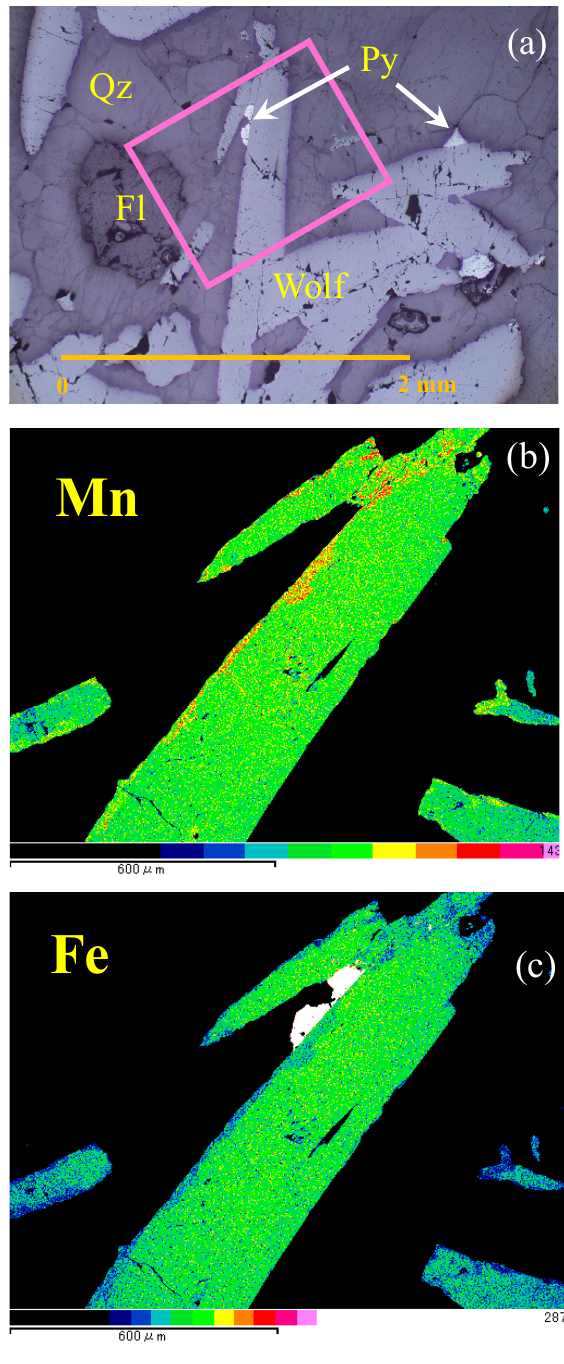
Figure 5. ( a ) Photomicrograph of a wolframite-bearing quartz vein with pyrite and fluorite (82032404) from No. 7 vein at W20 on level − 4L (57 m above sea level, Figure 4). Elemental maps of wolframite by SEM-EDS are shown for ( b ) Mn and ( c ) Fe. The analysis area for ( b , c ) is designated by the rectangular frame in Figure 5a. High content (Mn or Fe) corresponds to the right end of each color bar (qualitative scale). Qz: quartz, Wolf: wolframite, Py: pyrite, Fl: fluorite. Quantitative analyses of a wolframite grain (82032404, Table 1) from the No. 7 vein at − 4L (57 m above sea level, Figure 4) for Mn and Fe by EPMA are shown in Table 3 and Figure 6. The MnO/(MnO + FeO) ratio ranges from 42 to 65 mol%. The ratio in the center of the wolframite grain is around 43 mol%, while it increases to 65 mol% at the rims (Fig- ure 6). Wolframite grains without replacement textures also exist. An example of a wolf- ramite grain (82032411, Table 1) from the No. 7 vein at − 7L ( − 33 m below sea level, Figure 4) has a MnO/(MnO + FeO) ratio of 43 mol%, and no Mn enrichment is found in the rim. Table 3. Quantitative EPMA analyses of a wolframite grain (82032404; Table 1) from No. 7 vein at − 4L (57 m above sea level, Figure 4) for FeO and MnO. Analysis No.